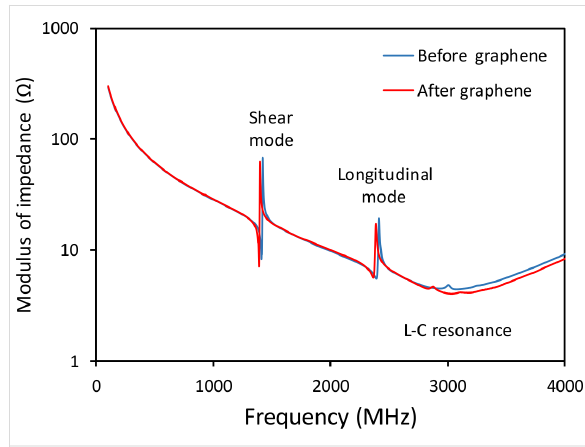
Figure 3: Electrical impedance spectra of the same device before and after graphene